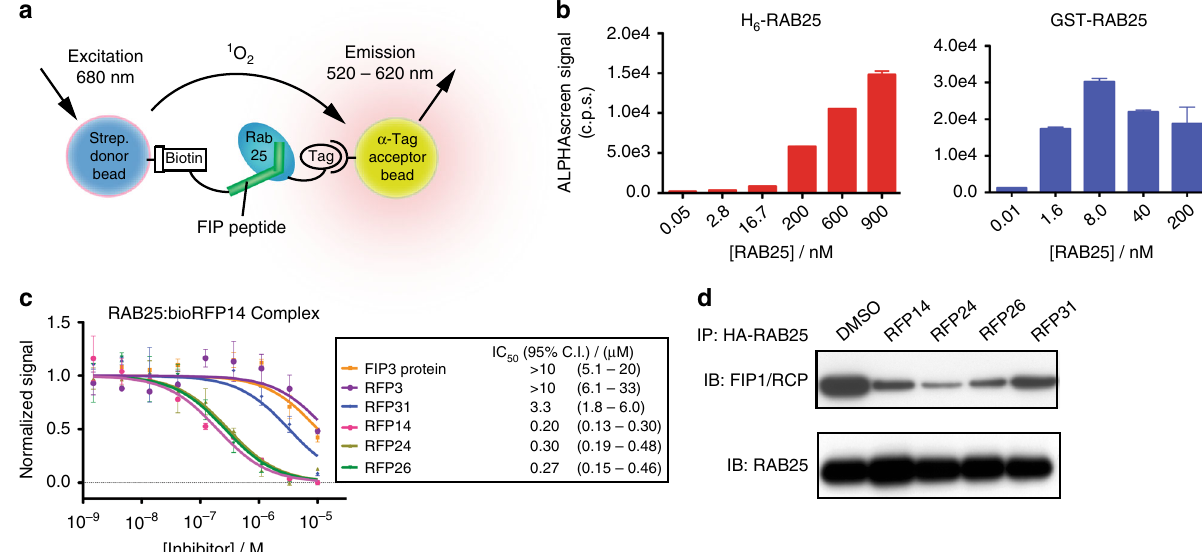
Fig. 3 RFPs form stable complexes with RAB25 and compete for FIP binding. a Schematic of the RAB25 ALPHAscreen proximity assay. Incubation of a synthetic, biotinylated-FIP-derived peptide with tagged (His 6 - or GST-) RAB25 leads to the formation of the soluble complex and proximal association of streptavidin-coated donor beads with acceptor beads (Ni 2+ -NTA or anti-GST). Donor bead excitation at 680 nm produces singlet oxygen, which selectively initiates a luminescent cascade in bound acceptor beads. b Bio-RFP14 binds H 6 - ( left ) and GST-RAB25 ( right ) in a dose-dependent manner, leading to robust ALPHAscreen signal. c Competitive inhibition of RAB25:RFP14 complex formation by soluble RFP and FIP peptide ligands. Constant H 6 -RAB25 (0.2 μ M) and bio-RFP14 (0.2 μ M) were incubated in the presence of indicated ligand concentrations prior to addition of ALPHAscreen reagents and reading of luminescent signal. d RFP stapled peptides (1 μ M) compete with HA-RAB25 binding and co-immunoprecipitation of FIP1 in HEY RAB25 cell lysate. These results are representative of experiments performed in triplicate. Binding data points represent the mean ± s.e.m. from triplicate measurements. IC 50 values represent mean with 95% con fi dence interval from triplicate replicates and application of a sigmoidal curve fi t using